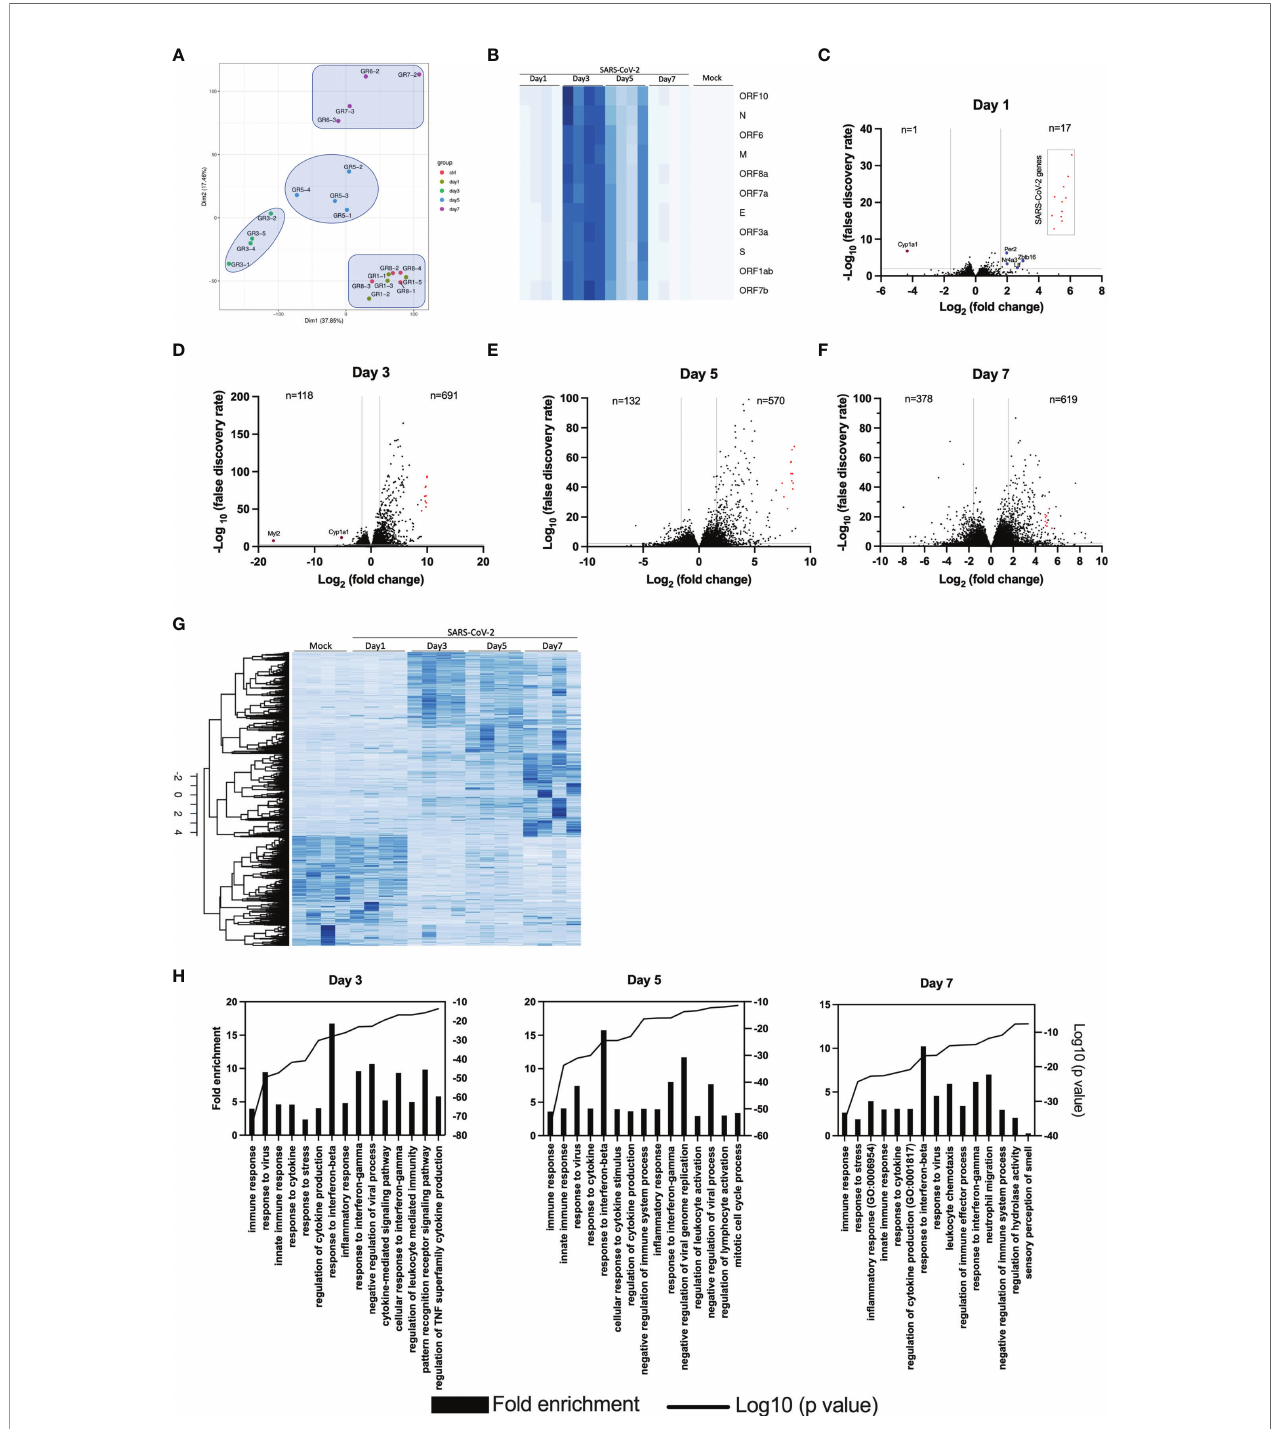
FIGURE 4 | Lung transcriptome analysis of SARS-CoV-2 infected mice. RNA from the lungs of mock and SARS-CoV-2-infected mice (n=4/group) were isolated on days 1, 3, 5 and 7 and subjected to RNA seq. (A) Principal component analysis on 20 samples with the normalized gene expression levels. (B) Heat maps showing the relative expression of SARS-CoV-2 genes at various times post-infection. The darker the color, the greater the expression. (C-F) Volcano plots comparing differentially expressed genes from samples taken at 1, 3, 5 and 7 days post-infection relative to mock-infected mice. Red dots indicate SARS-CoV-2 genes. The numbers in the left and right sections of the volcano plots represent the sum of downregulated and upregulated genes, respectively. (G) Heat map representation of cellular genes expression in mock and SARS-CoV-2 infected mice at different times post-infection. The darker the color, the greater the expression. (H) Gene Ontology enrichment analysis of biological process enriched from comparisons of mice at day 3, 5 and 7 post infection versus mock-infected